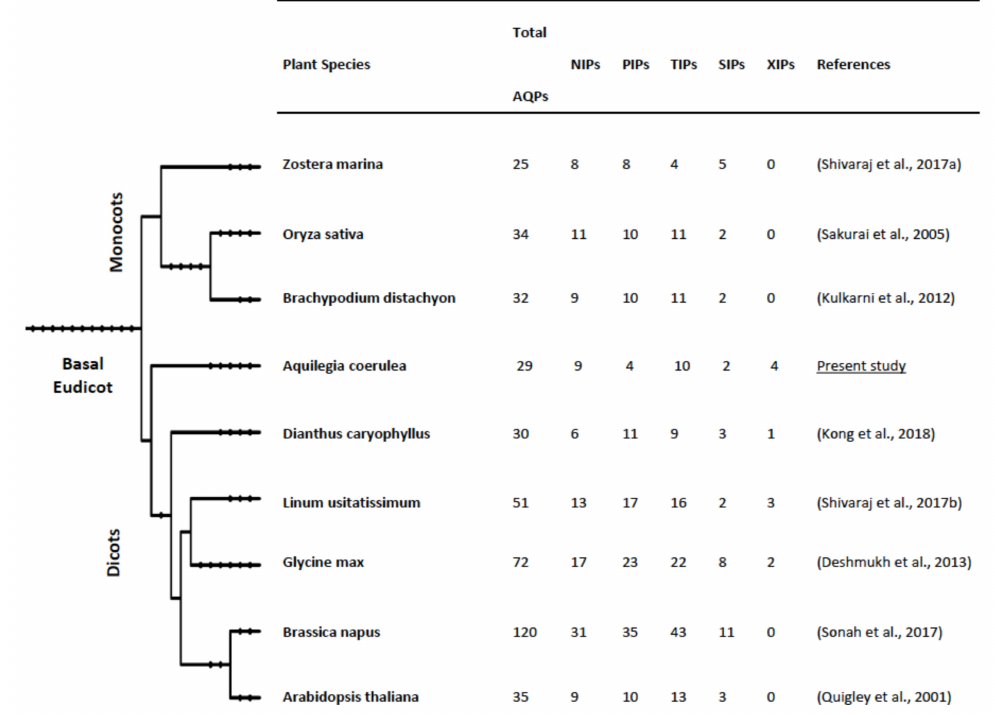
Figure 2. Distribution of the aquaporins and its sub-families, namely, PIPs (plasma membrane intrinsic proteins), TIPs (tonoplast intrinsic proteins), NIPs (nodulin 26-like intrinsic protein), SIPs (small basic intrinsic proteins), and XIPs (uncharacterized intrinsic proteins) in diverse plant species belonging to monocots and dicots. Phylogeny of the species was constructed using the Phylogenetic tree generator (http: // phylot.biobyte.de /